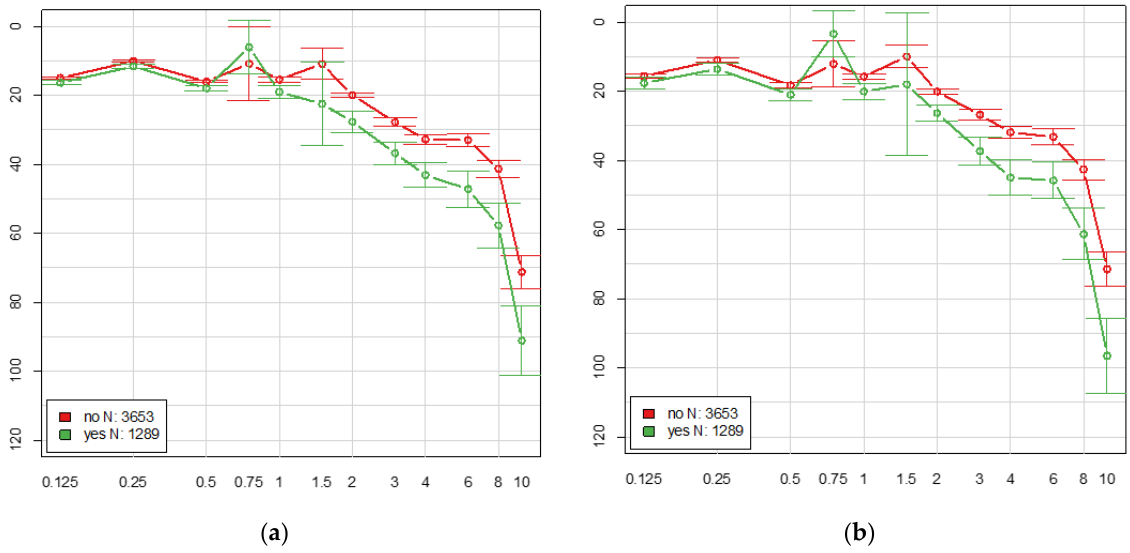
Figure 3. Mean hearing levels (pure-tone audiometry, air conduction), x-axis: frequencies in kHz, y- axis: mean hearing level in dB. ( a ) left ear, ( b ) right ear; red: participants without tinnitus, green: participants with tinnitus.